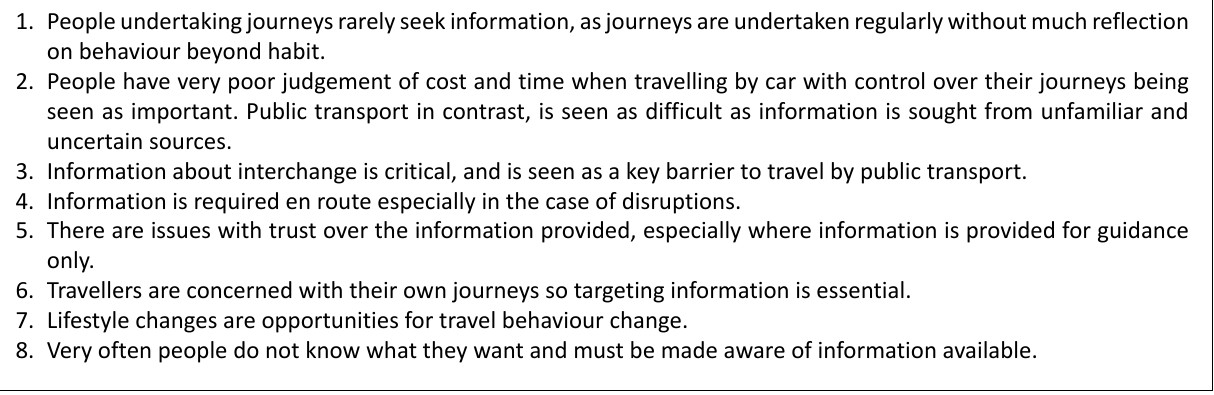
Figure 1. Traveller information and users (adapted from Lyons & Harman,